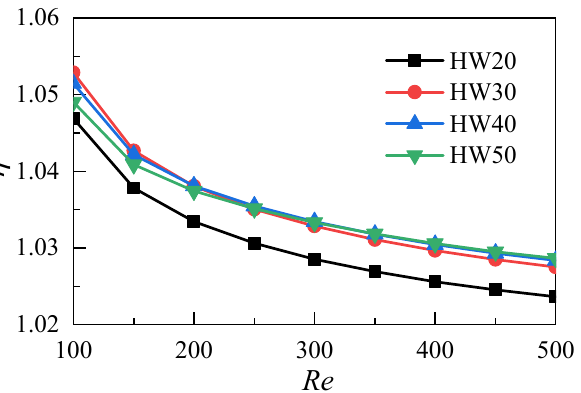
Figure 15. Comparisons of comprehensive heat transfer performances of microchannels with different